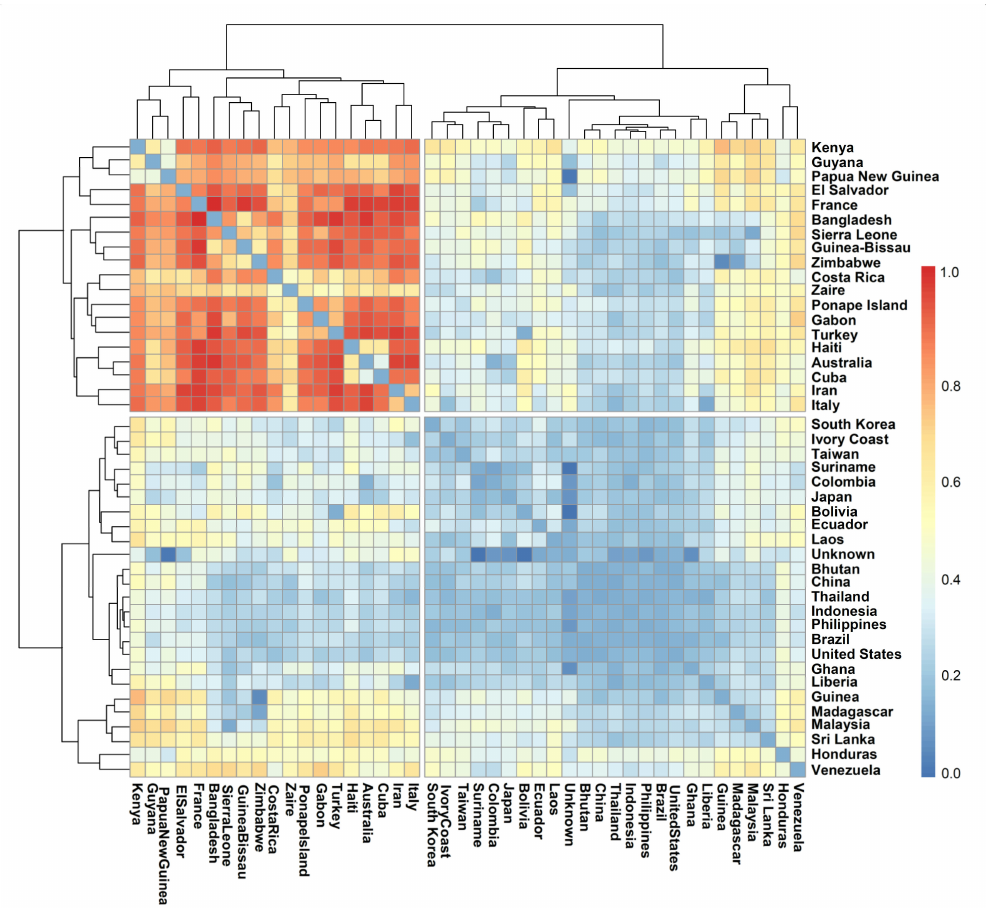
Figure 6. Pairwise FST matrix of tropical japonica lines based on their countries of origin. The population showed greater differentiation among 19 countries, while the rest of the population showed relatively little genetic